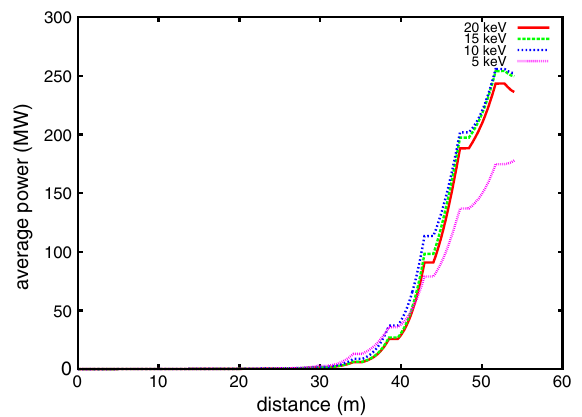
FIG. 12. Evolution of the 1 nm x-ray average radiation power inside the first section of the SASE undulator beam line using electron beams with 5, 10, 15 and 20 keV uncorrelated energy spread from the laser heater.